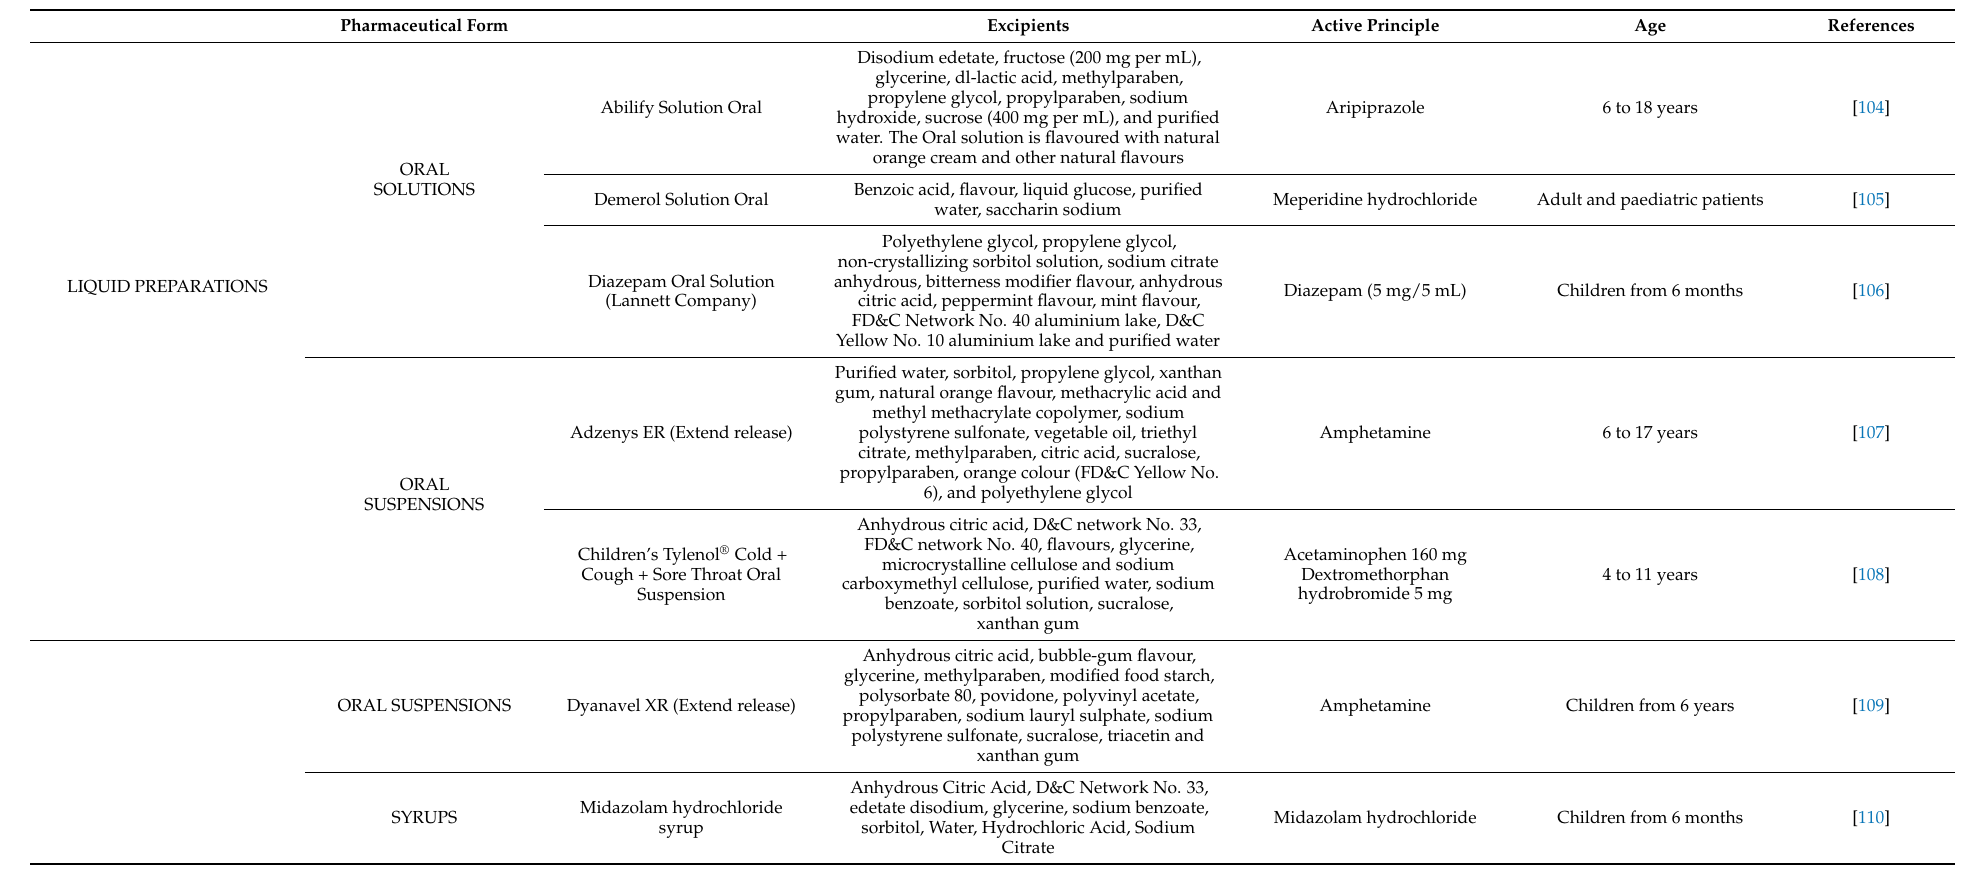
Table A4. Examples of FDA-registered drugs used in paediatrics (FDA and DAILYMED database consultation October